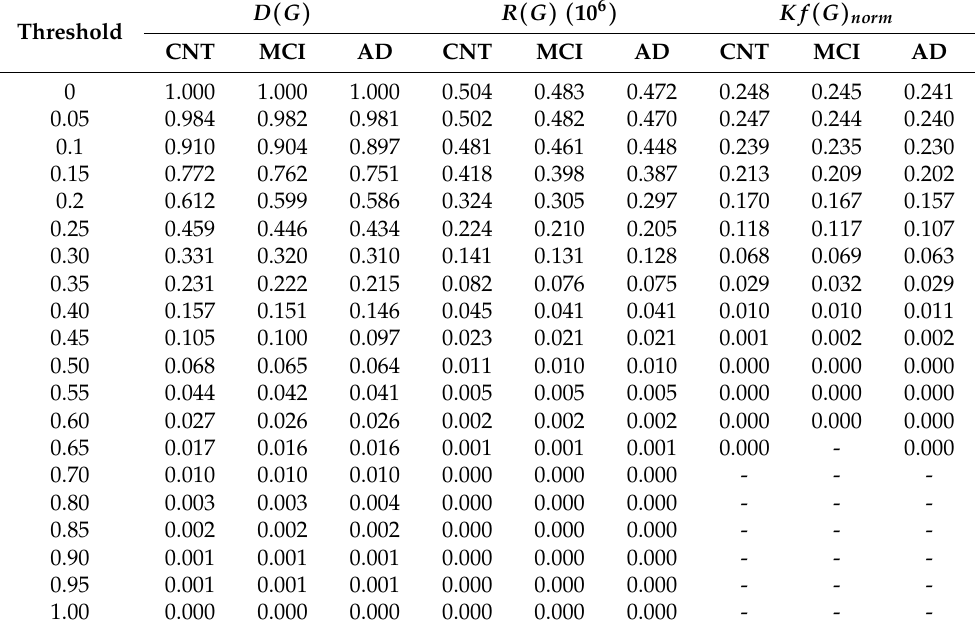
Table 3. Mean Connection Density Index, mean Randi´c Index, and mean Normalized Kirchhoff Index for CNT, MCI, and AD, for each filtering threshold